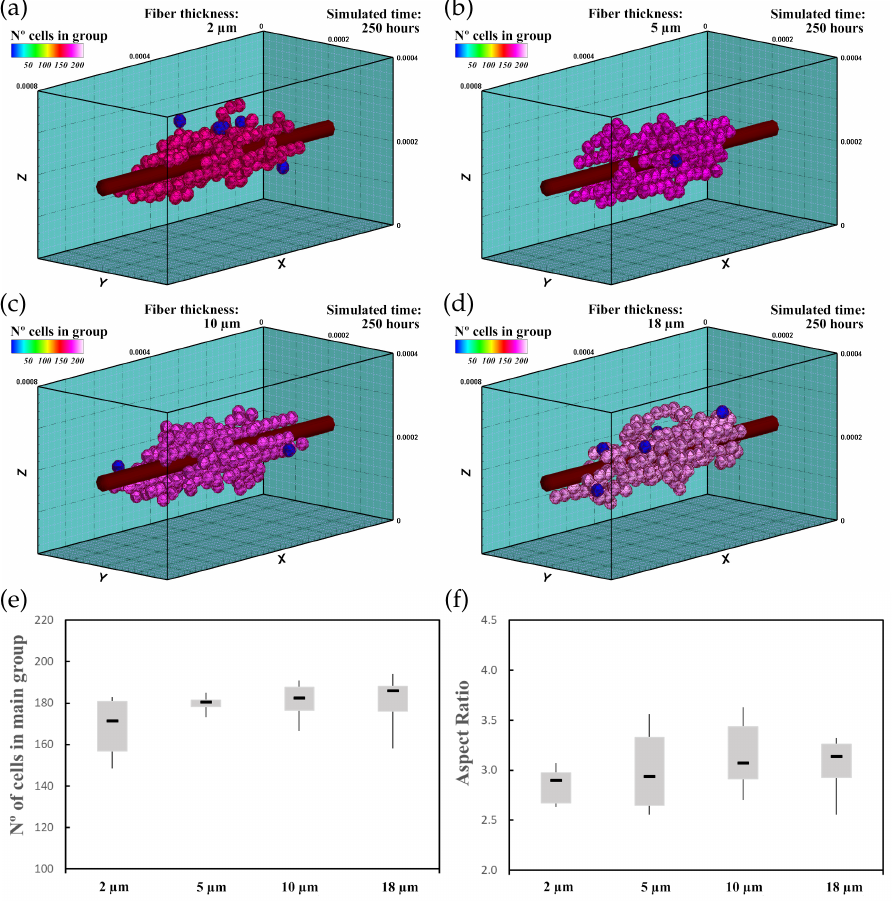
Figure 8. Group morphology and number of cells corresponding to an ECM with a central fiber thickness of 2 µ m ( a ), 5 µ m ( b ), 10 µ m ( c ), and 18 µ m ( d ). Cells migrate towards the central fiber where they keep moving and form the main group. As the fiber thickness increases, the mechanical stimulus is higher, which implies faster maturation rates and an increase in cell proliferation (see also Supplementary Material: S2). ( e ) Numerical results of the number of cells in the main group. ( f ) AR of the main